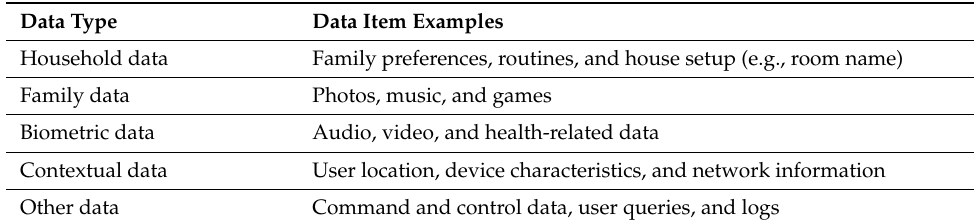
Table 3. An overview of data types collected by smart home